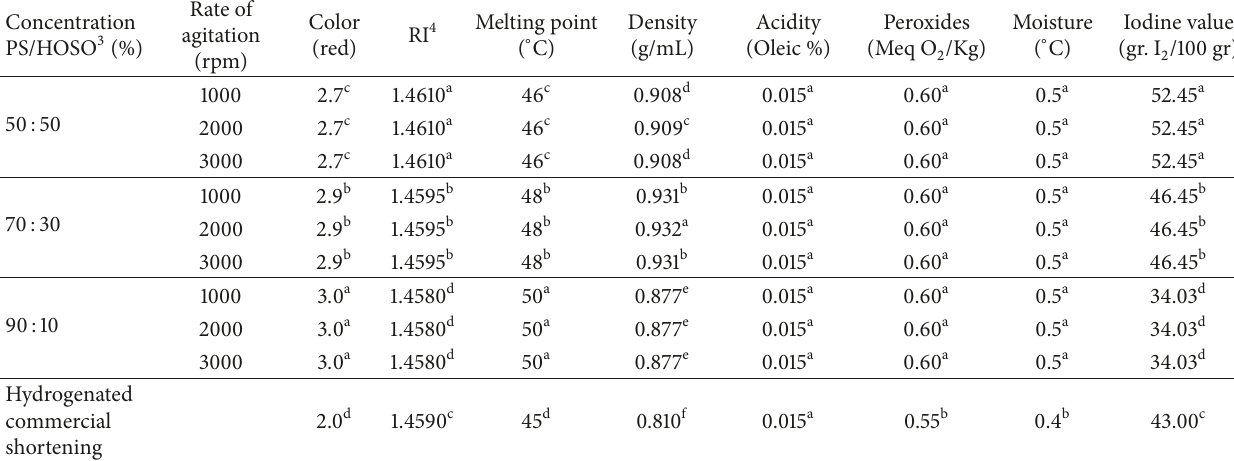
Table 2: Physical properties of zero-trans crystallized fats produced from palm stearin-high oleic safflower oil blends compared to hydrogenated commercial shortening 1,2